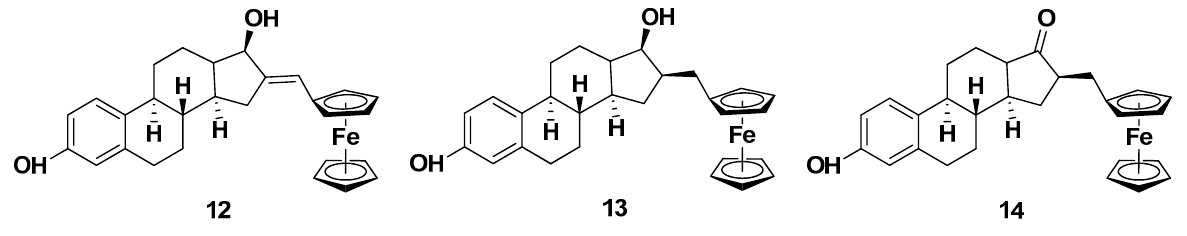
Figure 7. Ferrocene-steroid conjugates 12 – 14 . Table 4. Cytotoxicity of the ferrocene conjugates studied on hormone-dependent MCF-7 and T-47D and hormone-independent MDA-MB-231 breast cancer cell lines (MTT assay); data from [51].